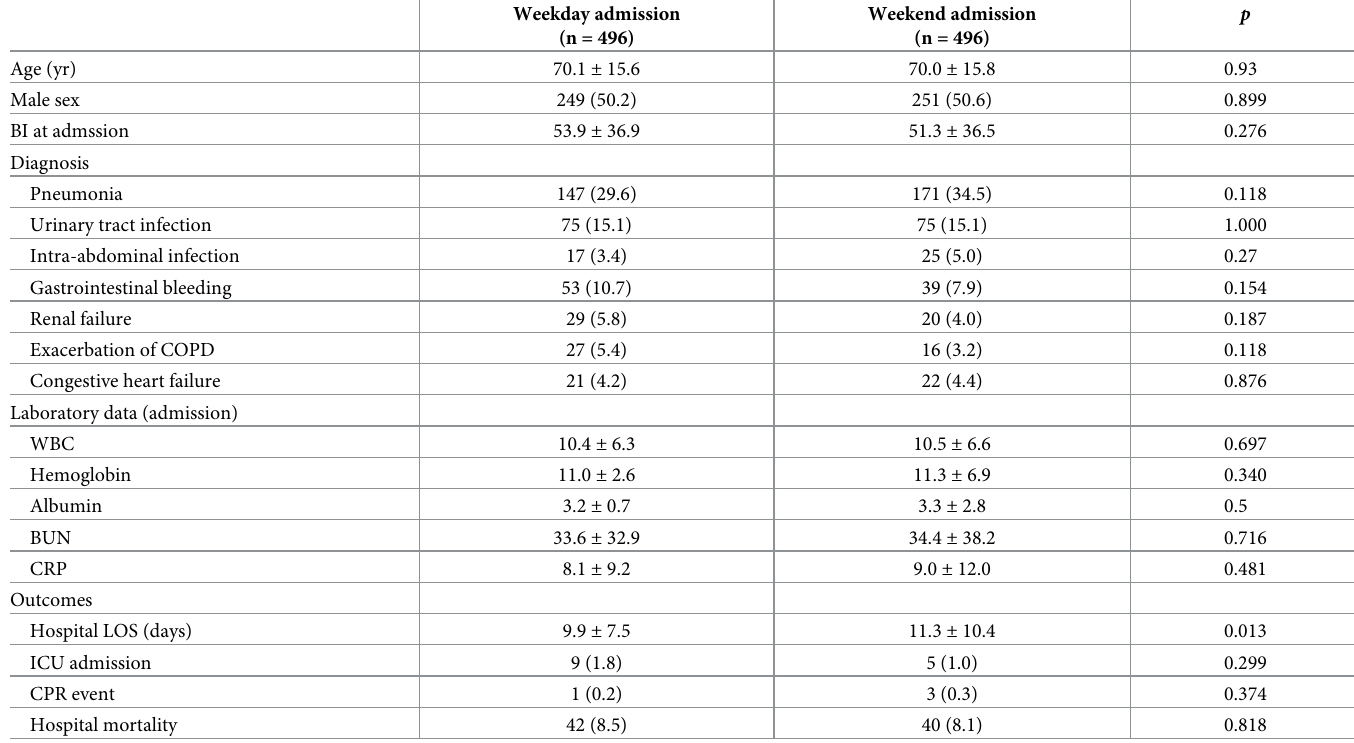
Table 5. Results of propensity score matching for weekday and weekend admissions in the hospitalist-care